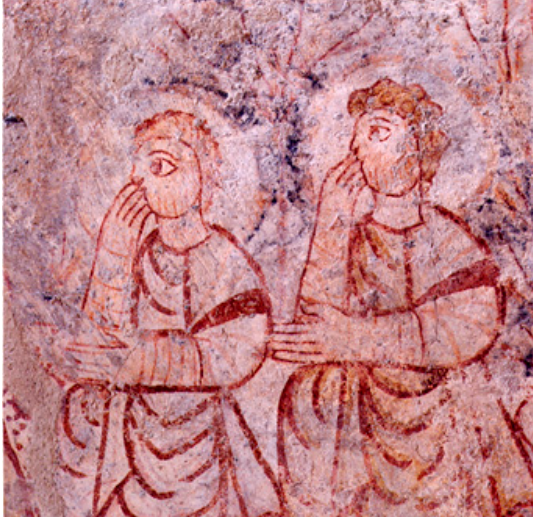
Figure 22. Sant Miquel de Terrassa, wall paintings. Detail of the Apostles. © Teresa Llordés (with kind